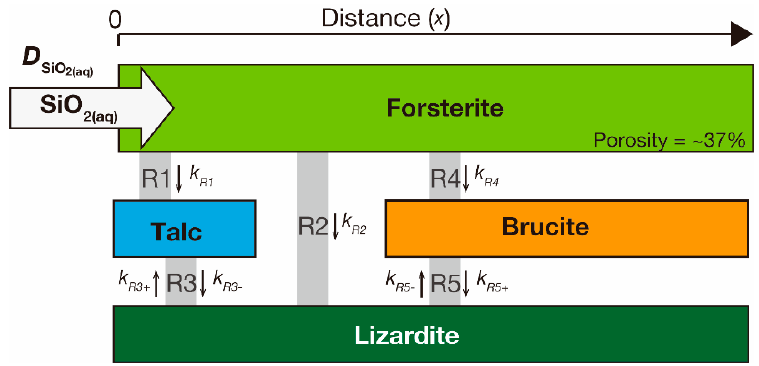
Figure 2. Schematic illustration of the reactive transport model considered in this study. At x = 0, SiO 2(aq) was transported by diffusion at a rate of D SiO2(aq) through the porous media of powdered forsterite, and secondary-mineral (talc, lizardite, and brucite) was produced. The gray bold line shows the overall reaction between two minerals. See Section 2.1 for details.